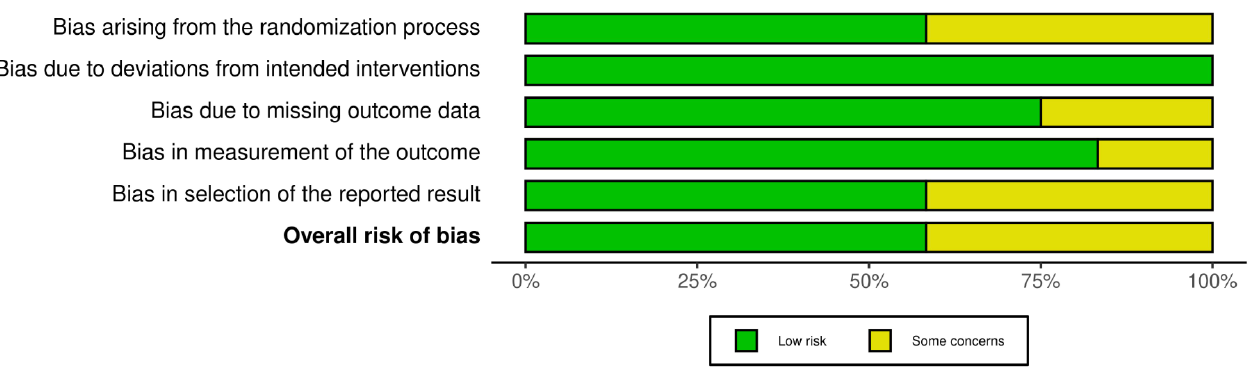
Figure 3. Risk of bias